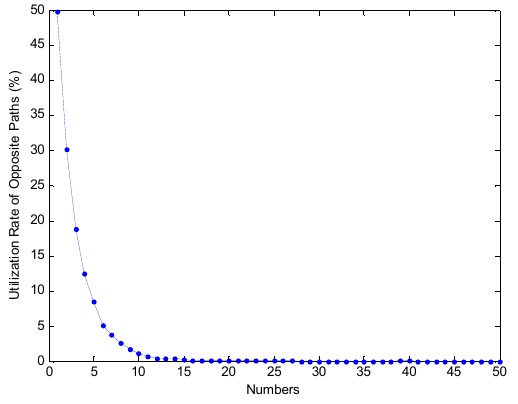
Figure 7. Utilization rate of opposite paths of OBBO